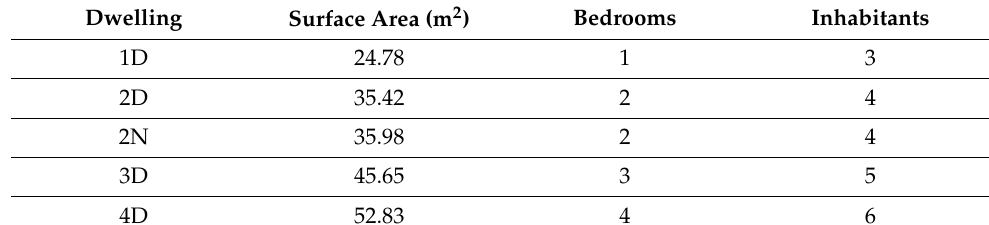
Table A2. Typologies of housing, surface, number of bedrooms, and inhabitants.